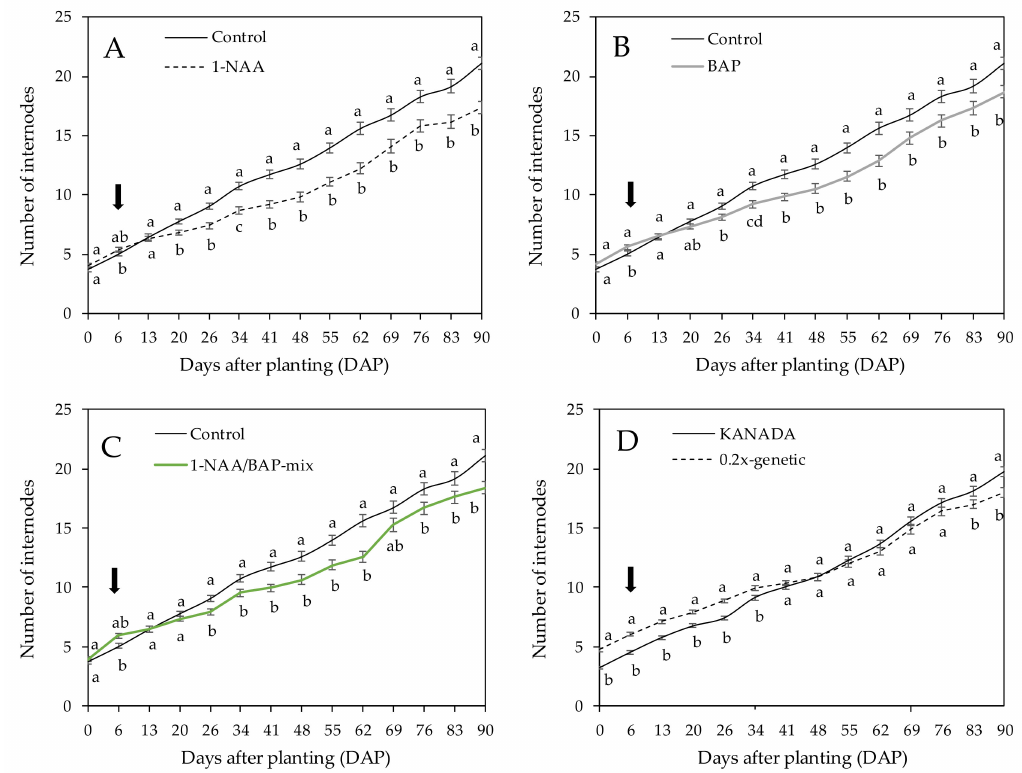
Figure 2. Mean number of internodes per axillary branch over two tested genotypes (KANADA and 0.2x-genetic) treated with ( A ) NAA, ( B ) BAP, and ( C ) NAA / BAP-mix, compared to the nontreated control over a time period of 90 days. ( D ) Mean number of internodes per axillary branch of genotype KANADA and 0.2x-genetic across time. Means covered with at least one identical lowercase letter did not di ff er significantly at α = 0.05. The arrow shows the time point (6 DAP) of the first